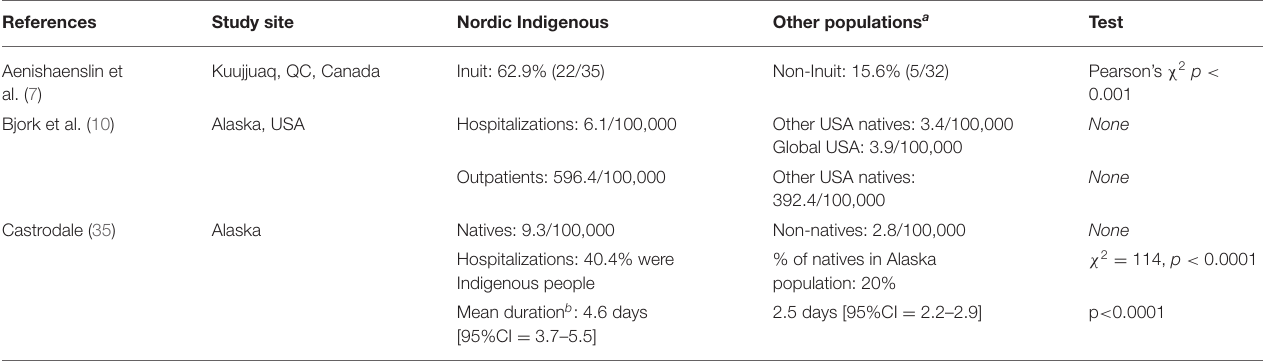
TABLE 3 | Comparison of dog bite occurrence between northern Indigenous populations and